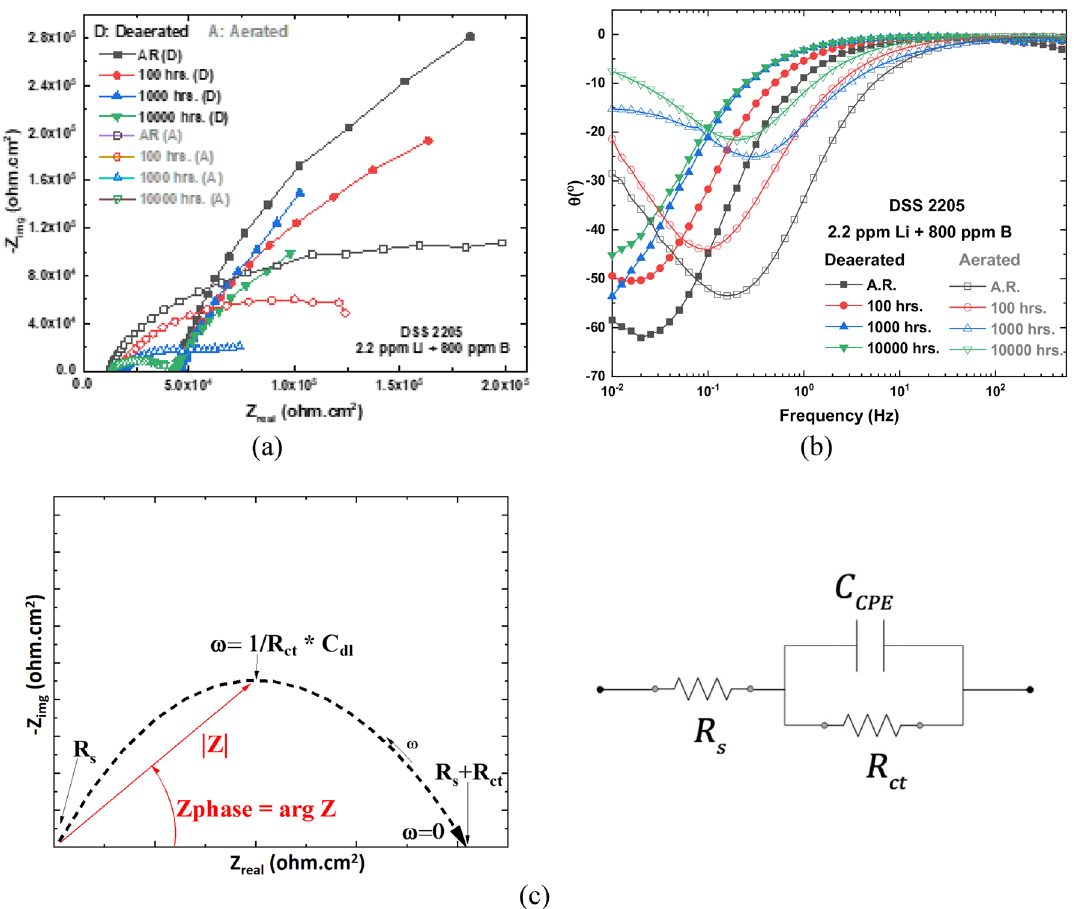
resentative Nyquist plot and corresponding simplified Randles cir- cuit used for modeling EIS data. ( ω = frequency; θ = phase angle; Z : impedance; Z : Imaginary impedance; Z : real img real